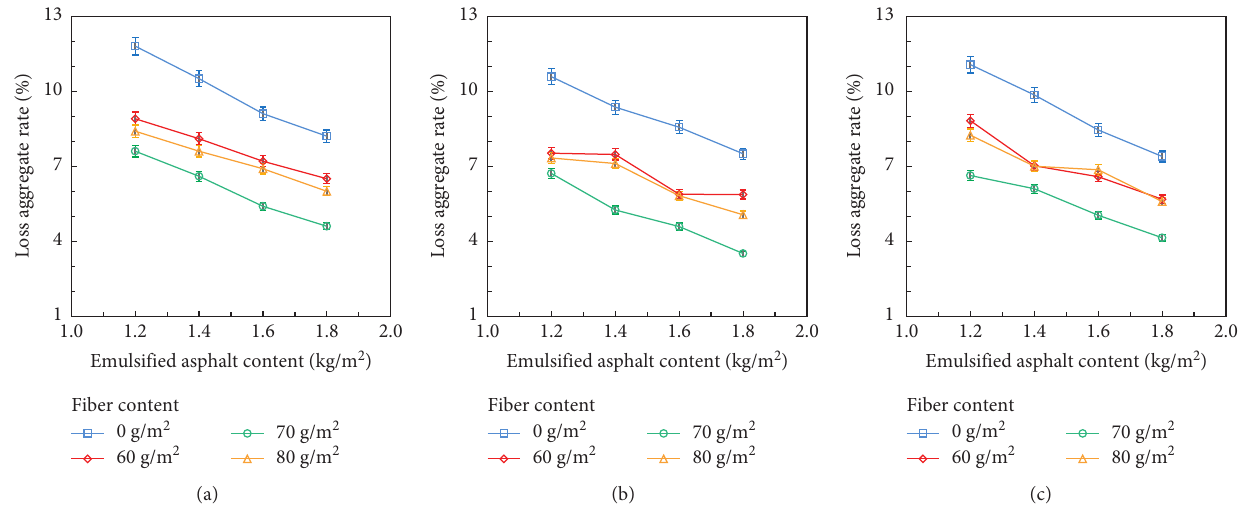
Figure 2: The loss aggregate rate with the basalt fiber. (a) 10 mm basalt fiber. (b) 15mm basalt fiber. (c) 20 mm basalt